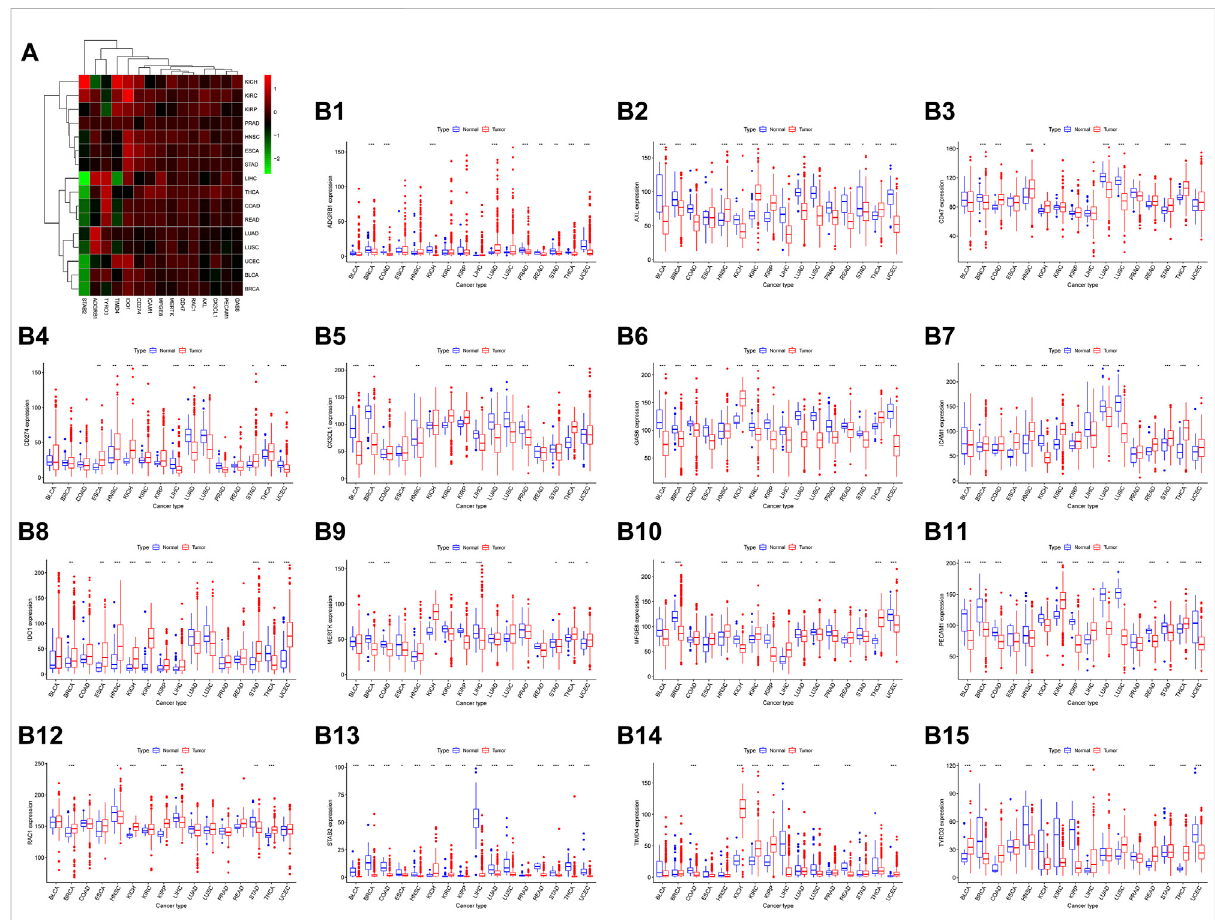
FIGURE 2 The expression level of 15 efferocytosis-related molecules in 16 types of cancers. (A) . Heatmap and supervised clustering of efferocytosis- related molecules with changed expression in 16 tumor tissues compared to that in normal tissues. (B1-B15) . The changed expression of ADGRB1 (BAI1), Axl, CD47, CD274 (PD-L1), CX3CL1, Gas6, ICAM1, IDO1, MerTK, MFGE8, PECAM1 (CD31), RAC1, STAB2, TIMD4 (Tim-4), and Tyro3 in 16 tumor tissues compared to that in normal tissues. * p < 0.05, ** p < 0.01, *** p < 0.001 as assessed by the Wilcoxon signed-rank